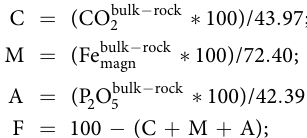
and then determine rock type in accordance with the classification by mineral composition (Fig. 2).